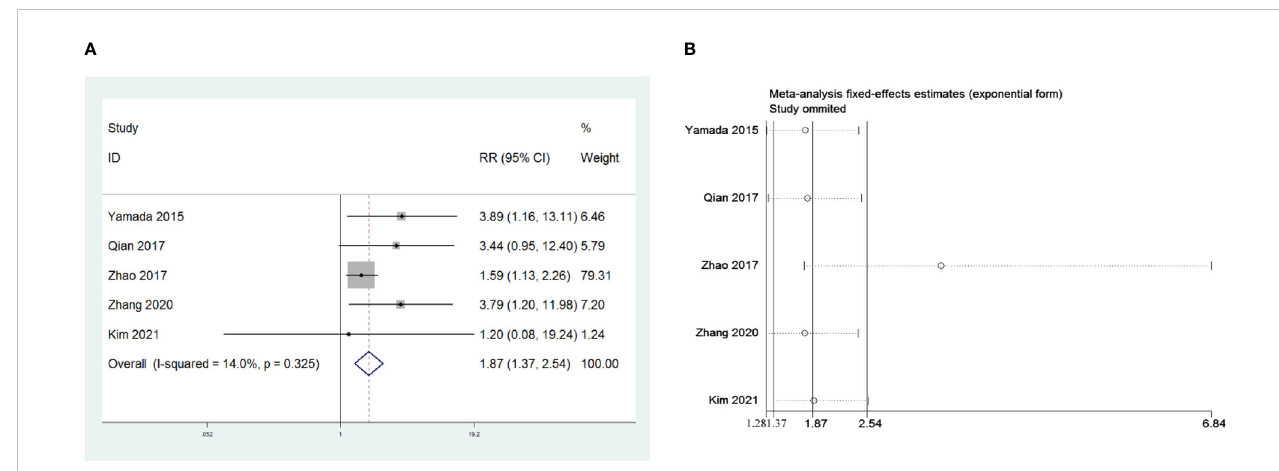
FIGURE 5 (A) Meta-analysis of the in fl uence of complete thymoma resection on PMG. (B) Sensitivity-analysis of the in fl uence of complete thymoma resection on